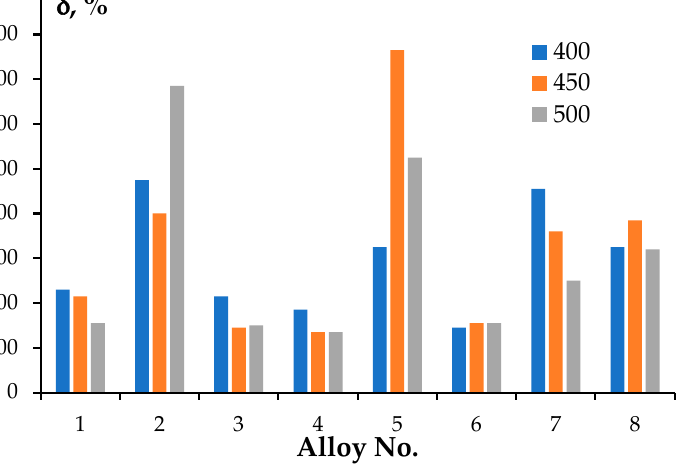
Figure 11. Elongation to failure in various alloys tested at 400, 450 and 500 °C. Strain rate of 3.3 × 10 − 3 s − 1 .